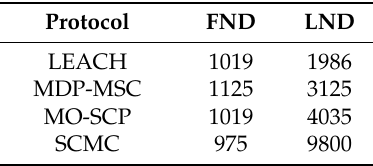
Table 4. Nodes die-off statistics of the different approaches.